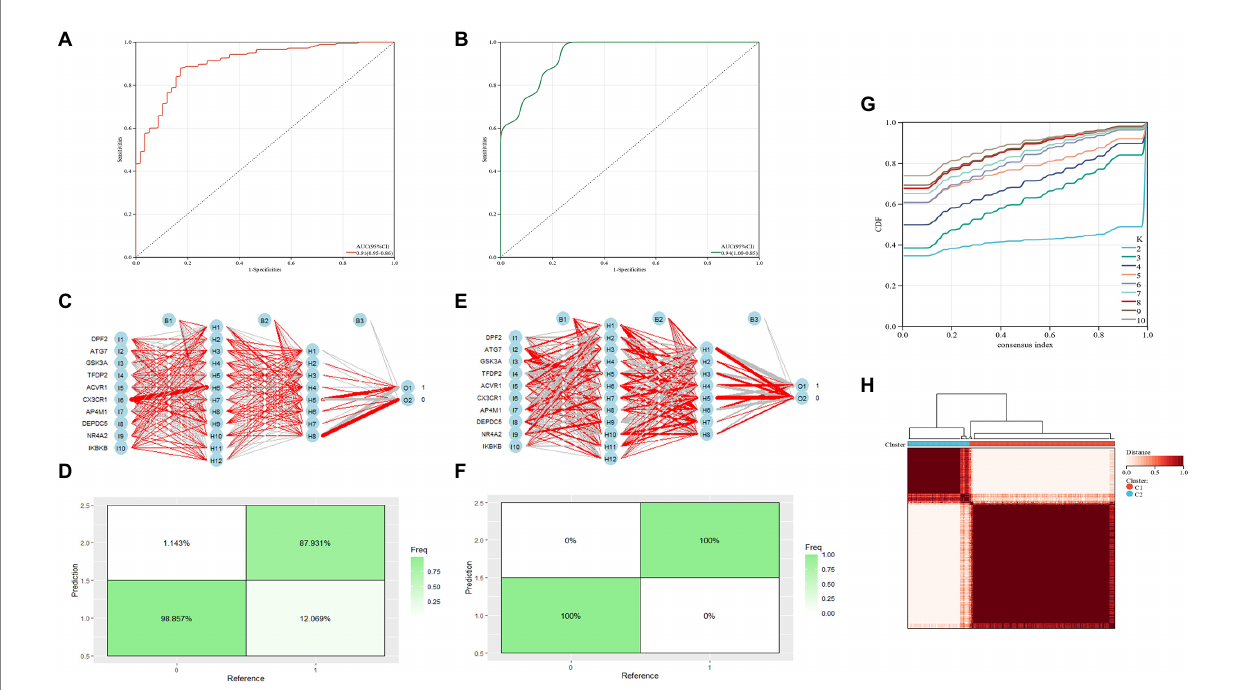
FIGURE 5 (A) Training group ROC curve; (B) Test group ROC curve; (C,D) Validation of the artificial neural network of the training group; (E,F) validation of the artificial neural network of the validation group; (G,H) CC analysis of the related gene model.